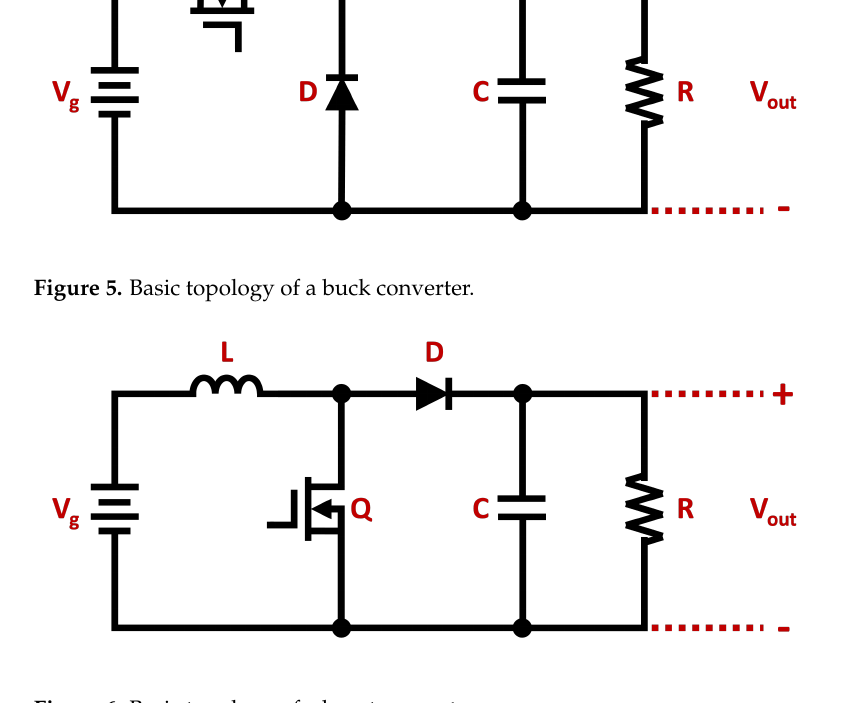
Figure 6. Basic topology of a boost